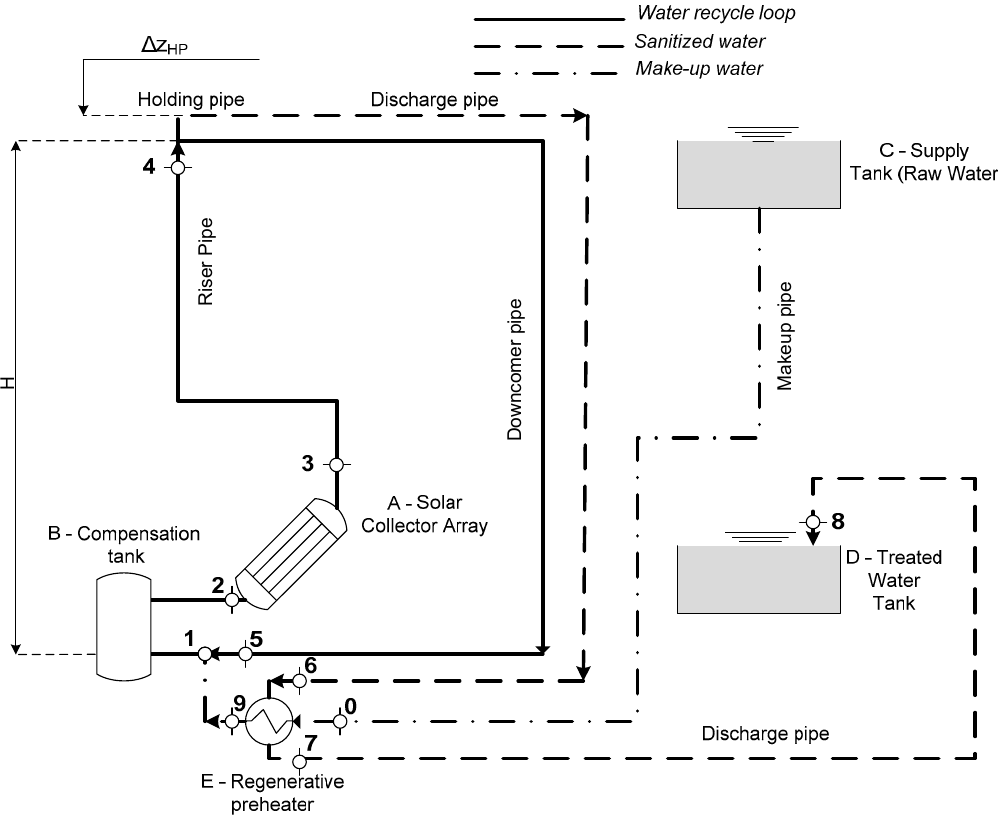
Figure 1 . Natural recirculation of a solar pasteurization system. Figure 1. Natural recirculation of a solar pasteurization